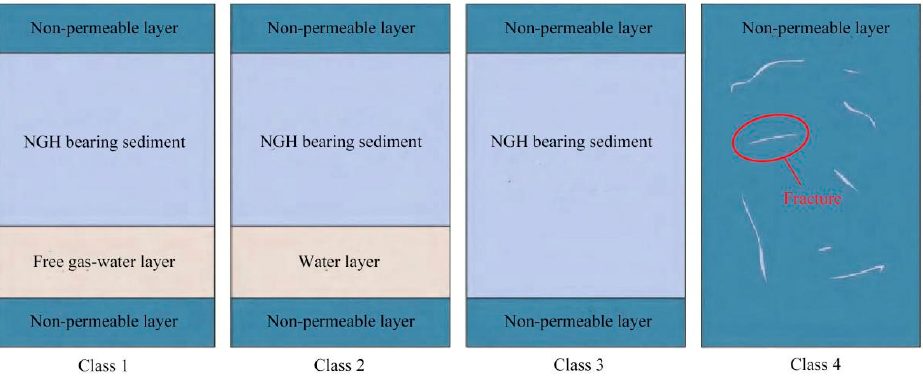
Figure 6. The classification of hydrate